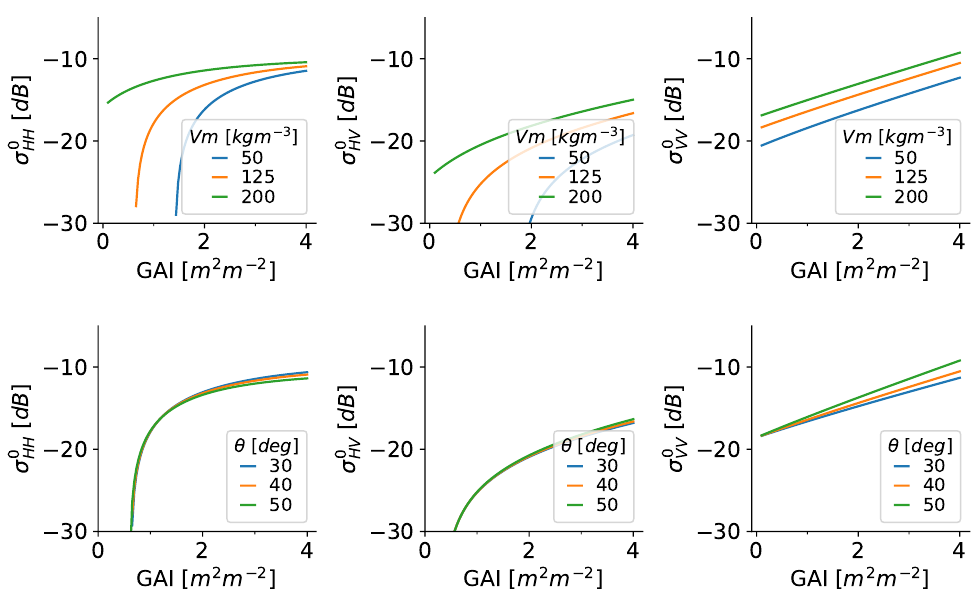
Figure 7. Backscattering coefficient simulations σ 0 in polarization HH, HV, and VV as a function of GAI ( top ) for multiple values of volumetric surface soil moisture, V m , with the incidence angle θ = 40 ◦ , and ( bottom ) for multiple incidence angles, with V m = 125kgm − 3 .